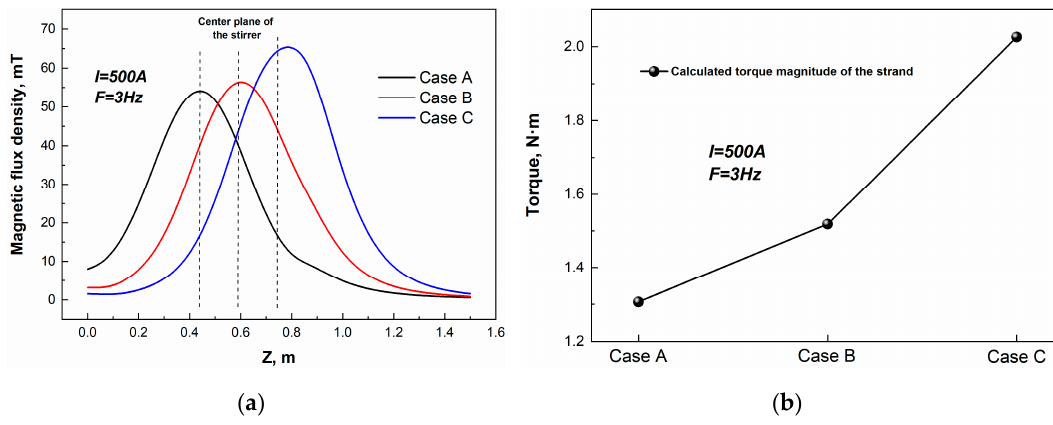
Figure 15. ( a ) Distribution of magnetic flux density at the centerline of strand along the casting direction; ( b ) Electromagnetic torque of strand under different stirrer installation positions.